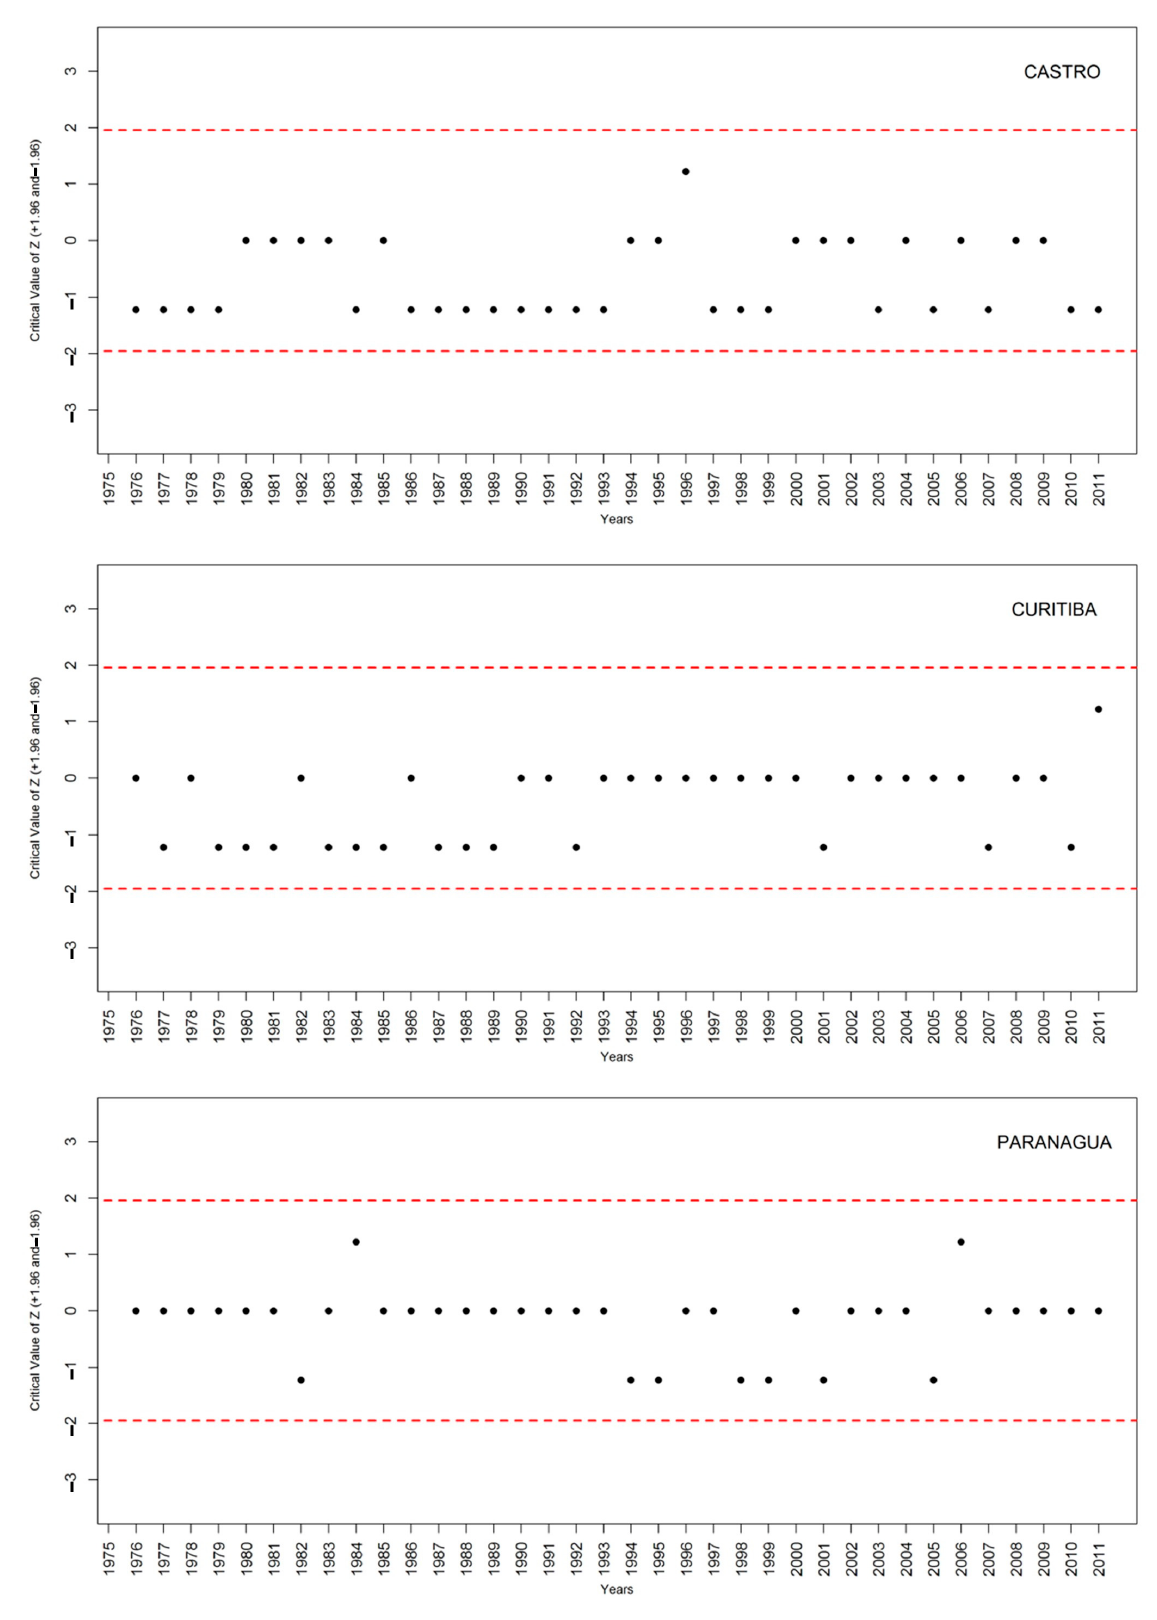
Figure 6. Run test results in the seasonal scale.